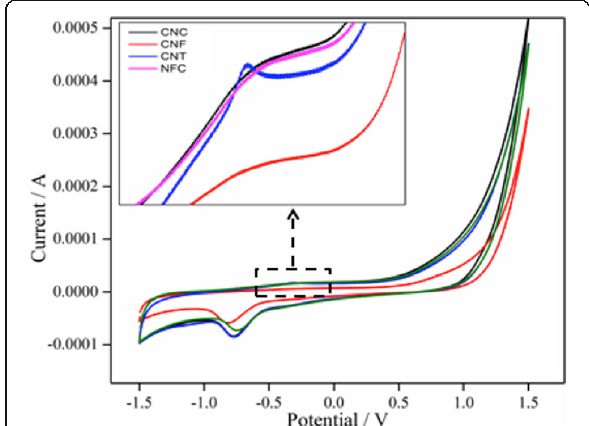
Fig. 4 Cyclic voltammograms of CNC, CNF, CNT, and NFC in PBS buffer solution (pH 7.0). Scan rates: 0.1 Vs − 1